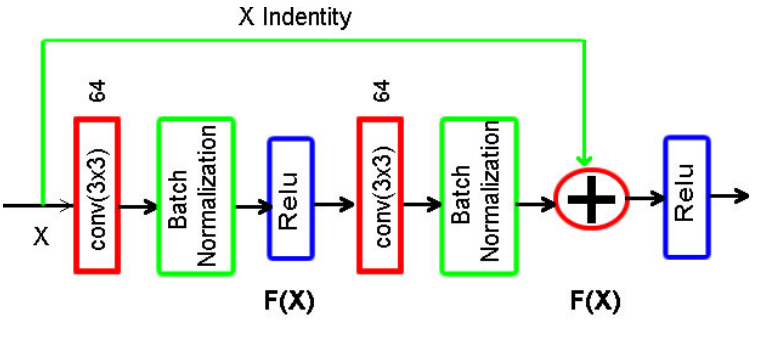
Figure 7. ResNet